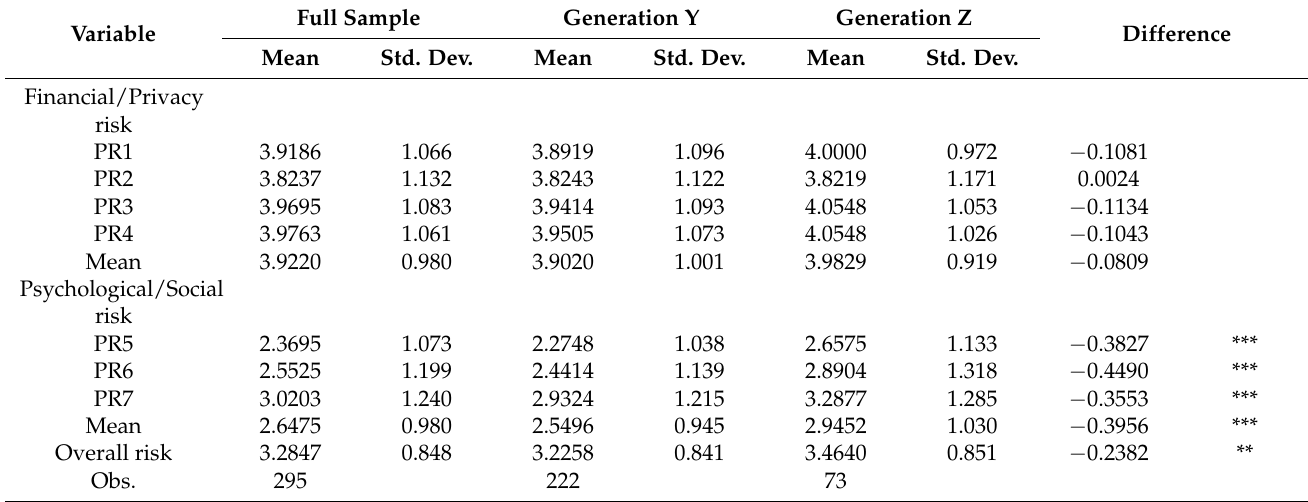
Table 8. Mean scores of perceived